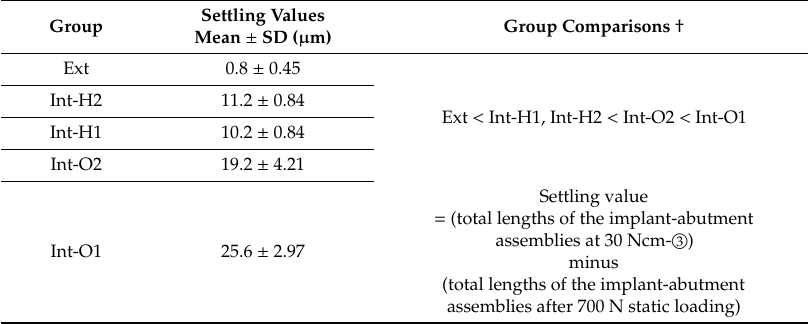
Table 3. Mean settling values after 700 N static loading in each group and multiple comparisons using Tukey’s honestly significant di ff erence